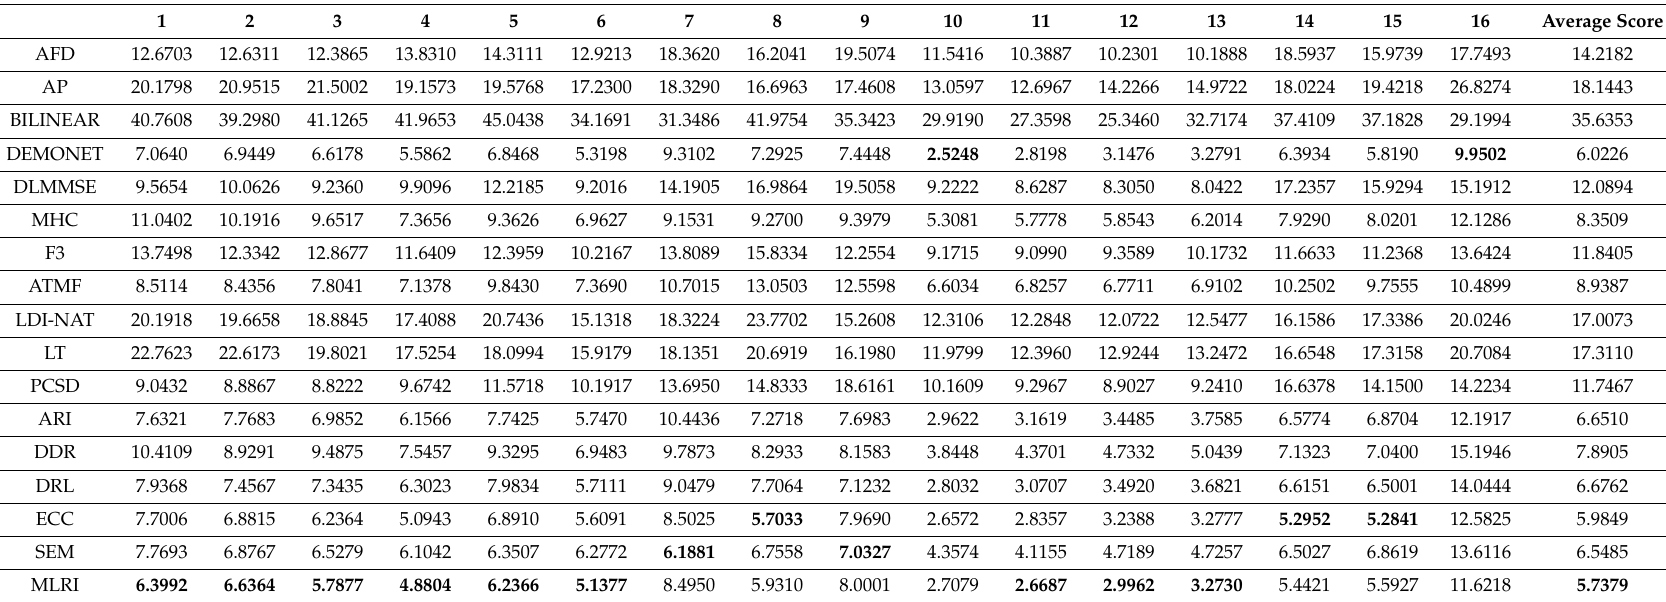
Table 2. Summary of NIQE scores (lower means better). Sixteen left images: Green